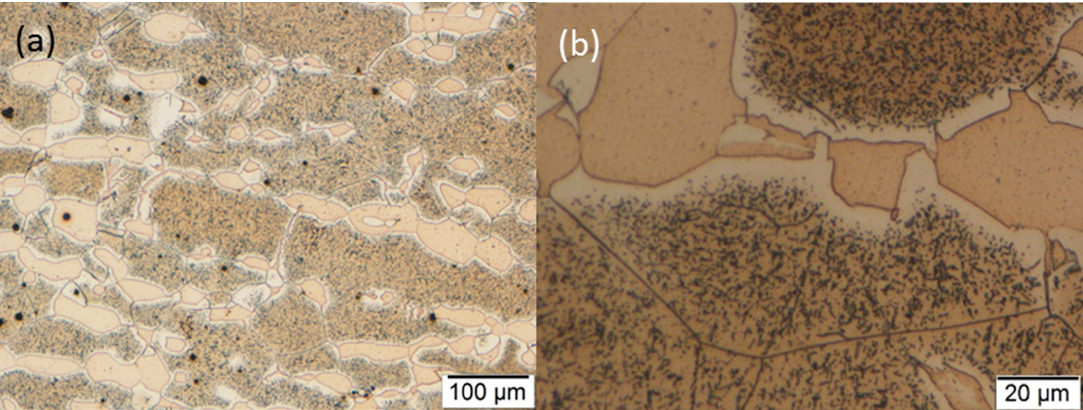
Figure 8 . Optical microscopy of the sample that was isothermally annealed at 650 °C, etched with 10% nital, ( a ) ferrite–– light brown, and austenite––dark brown with visible precipitation, ( b ) magnified detail, there is a strong precipitation on the ferrite–austenite and austenite–austenite grain boundaries.